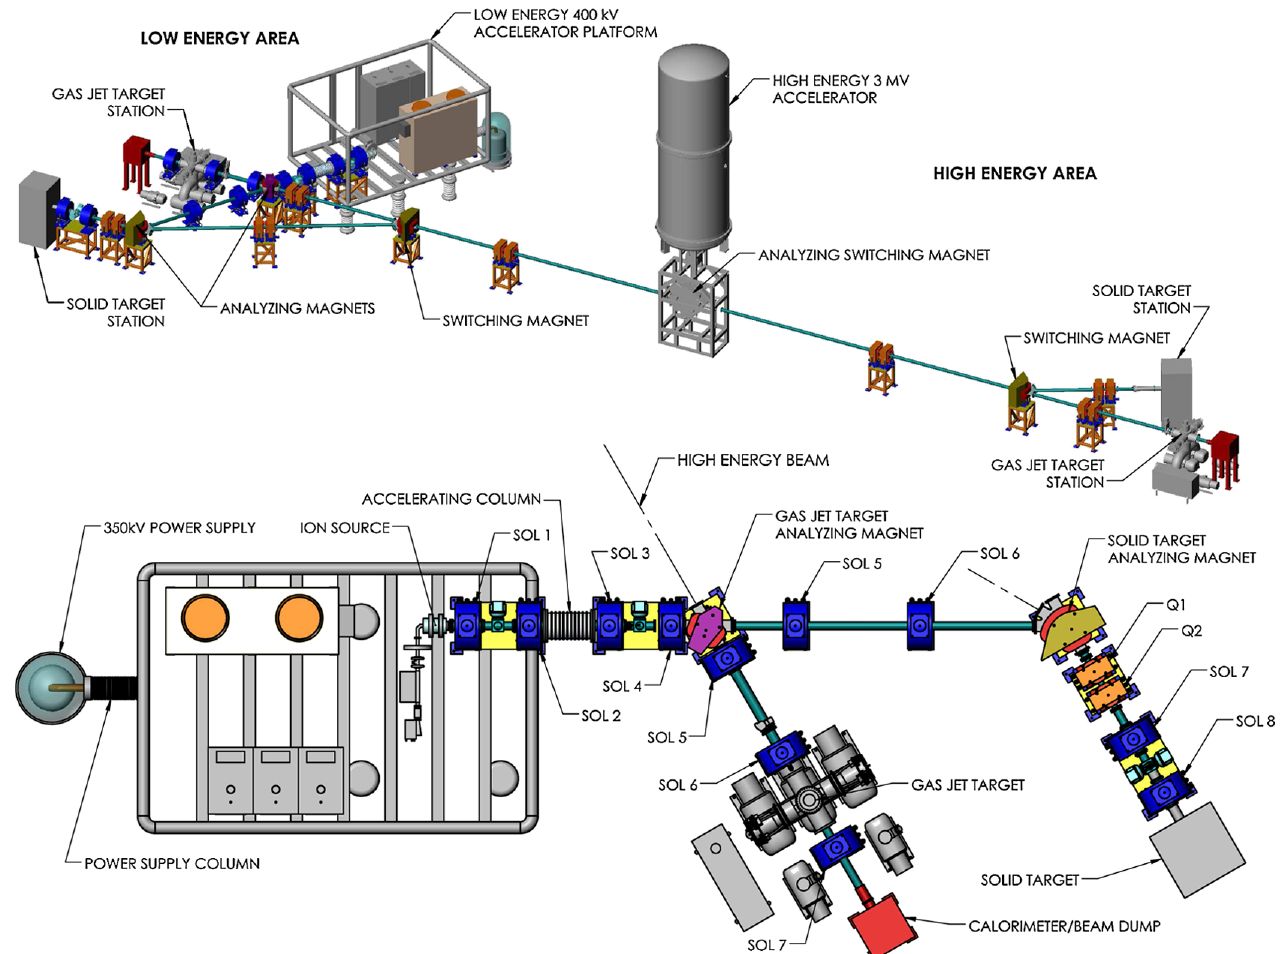
FIG. 1. Top: View of the DIANA accelerator facility. Bottom: The 400 kV accelerator, gas-jet, and solid-target stations